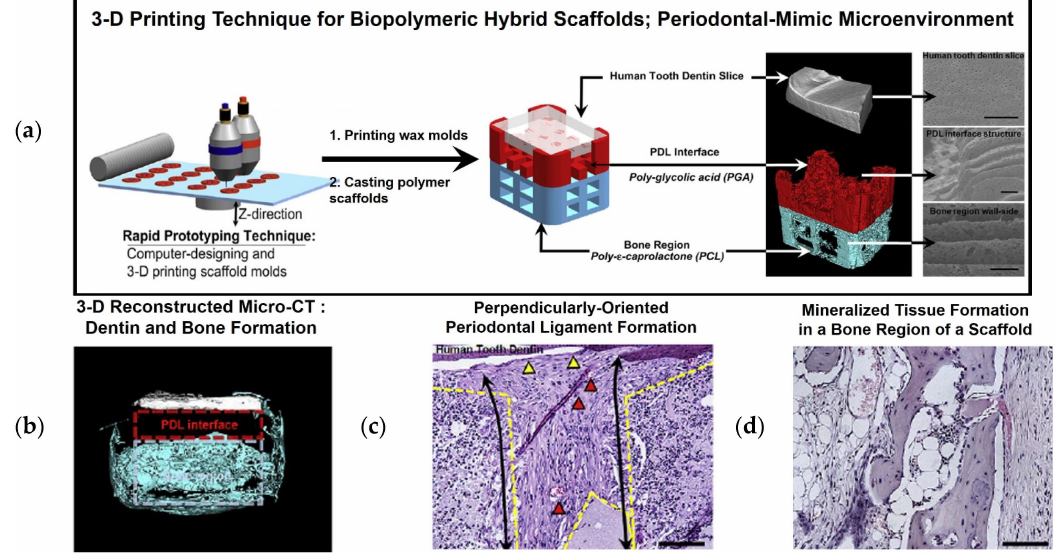
Figure 5. Proof-of-concept using a periodontal-mimic scaffolding system with a human dentin slice. ( a ) CAD-based 3-D wax molds were manufactured and cast with biodegradable polymeric materials, including poly-glycolic acid (PGA) for the PDL interface in red and poly- ε -caprolactone (PCL) for the bone region in blue. ( b ) Micro-CT and ( c , d ) histological image assessments. In the micro-CT image, mineralized tissue (blue) was spatially formed in a bone region of the hybrid scaffold without bone infiltration into the PDL interface (red dashed line). Histologically, dense fibrous connective tissues formed with blood vessels (red triangles) in a perpendicular orientation (black arrows), and cementum-like tissues underwent limited deposition on the dentin surface (yellow triangles). Bone region exhibited mineralized tissue formation. The scale bar: 50 µ m